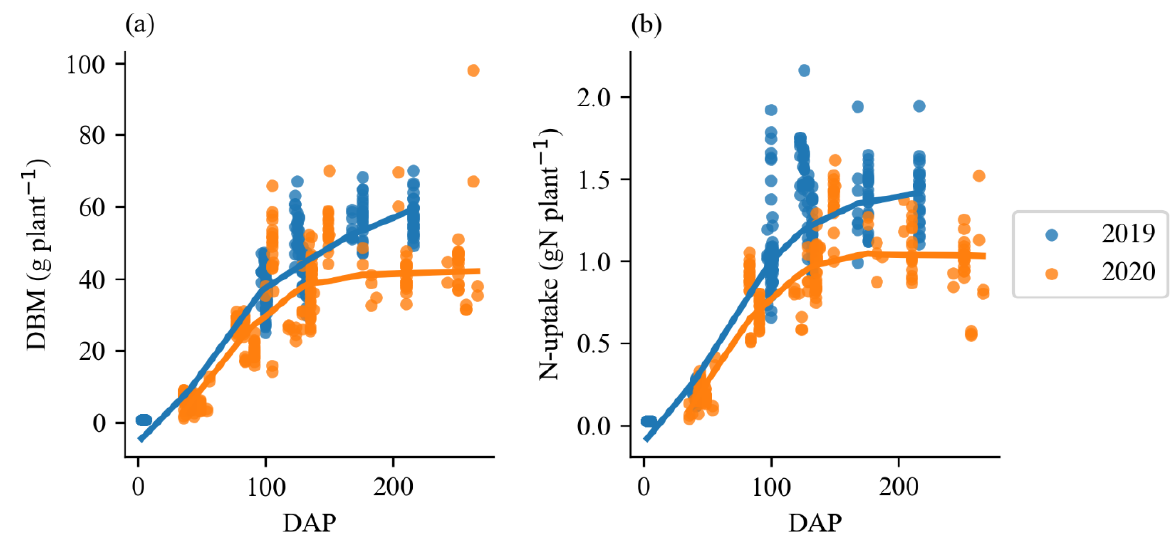
Figure 4. The evolution of ( a ) the DBM (g plant − 1 ) and ( b ) the N-uptake (gN plant − 1 ) across all experimental plots in 2019 (blue) and 2020 (orange) in function of the days after planting. The solid line is a lowess smoother.